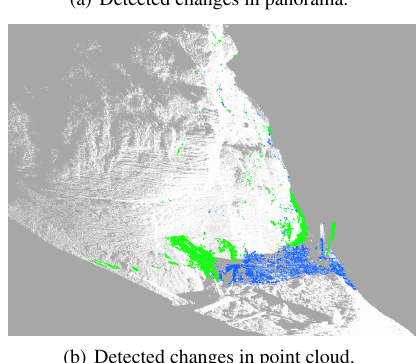
Demonstration of the three-dimensional characterization and anal- ysis along different surface trends are shown in Figs. (5) and (6), presenting deposition and erosion between epochs, respectively, while Fig. (7) shows an overview of the entire study-site, in par- ticular the storm induced failure. Fig. (5) focus on part of the cliff where horizontal and vertical erosion can be observed, as well as changing magnitudes of change: at the top of the cliff there are small changes that are difficult to trace without designated range data, while at the bottom a new notch has been created.